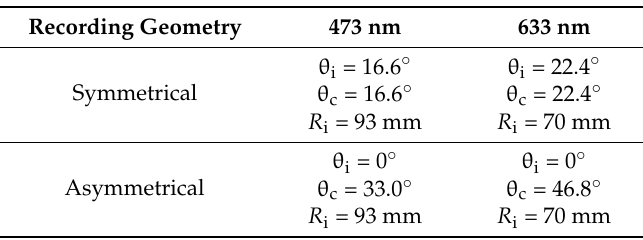
Table 2. Parameters for the evaluation of the